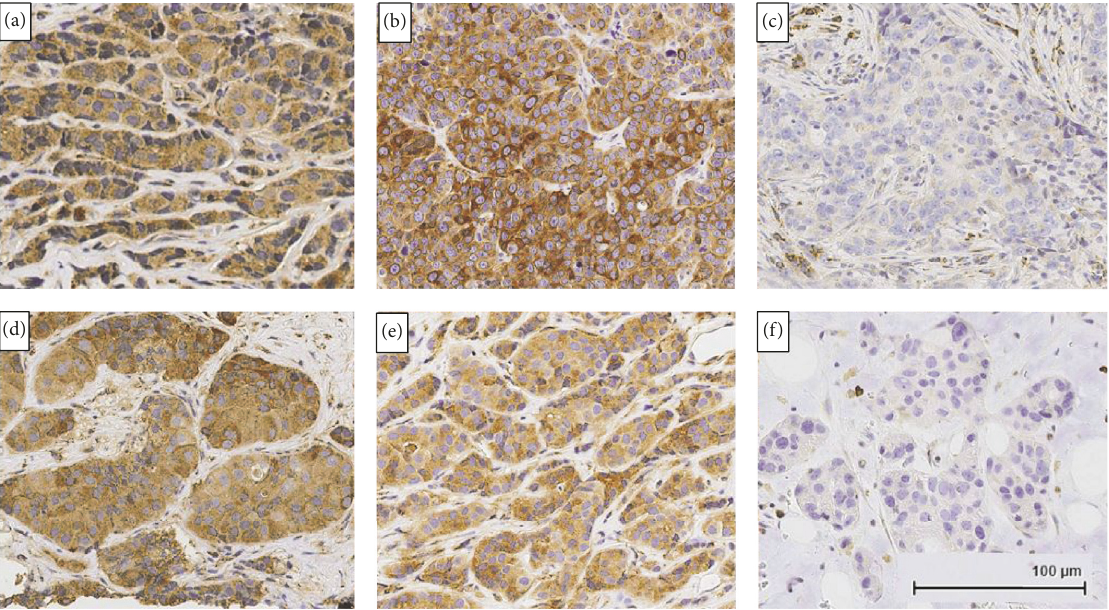
Figure 2: P-Rex1 immunohistochemical expression in primary breast cancers and metastatic sites. (a) Primary ER+ tumor with high expression. (b) Primary HER2+ tumor with high expression. (c) Primary triple-negative tumor with no detectable expression in malignant cells. (d) HER2+ lung metastasis with high expression. (e) ER+/HER2 − brain metastasis with high expression. (f) ER+/HER2 − bone metastasis with no detectable expression in malignant cells. All images were obtained at 200x magnification.